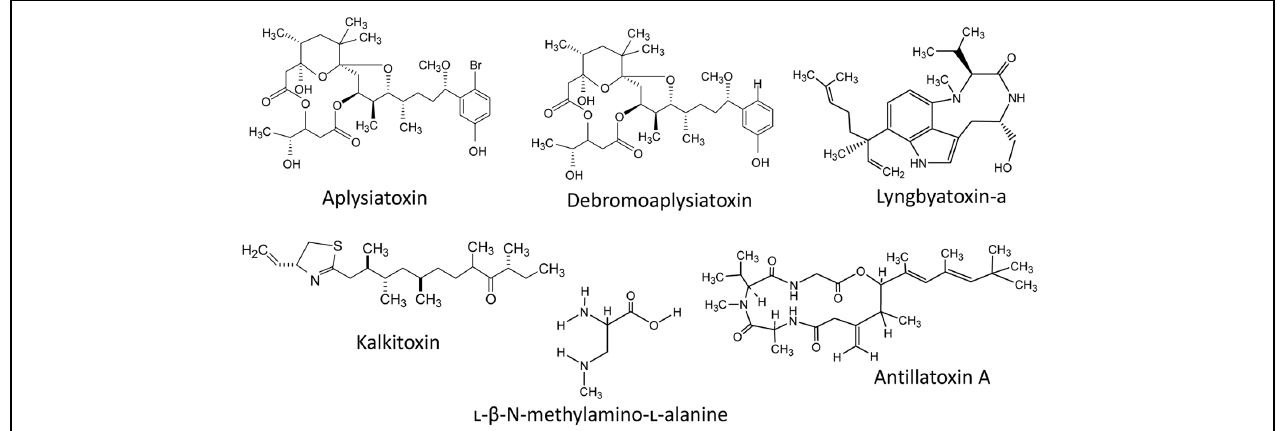
FIGURE 7 | The chemical structure of some common cyanotoxins reported in diverse